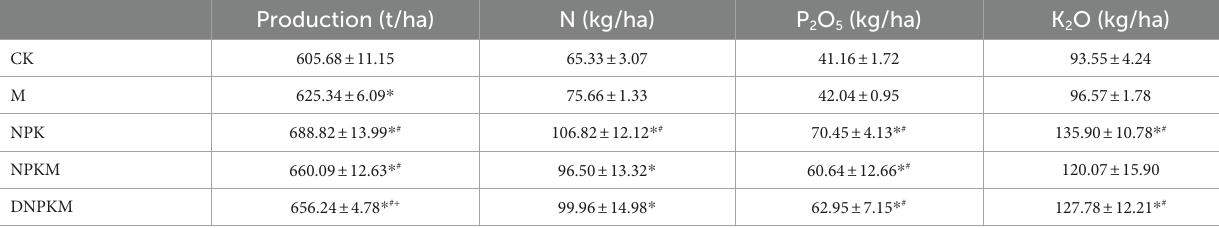
TABLE 3 3-year production and nutrient contents of cucumber in different fertilizer treatments.